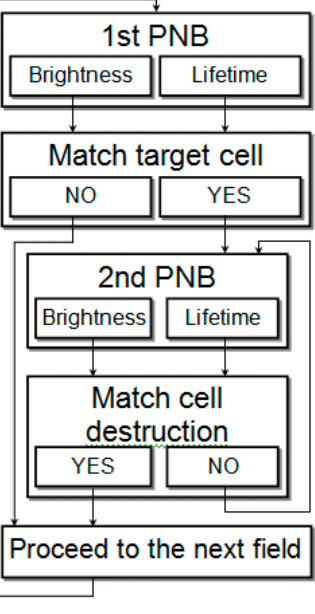
Figure 16. Algorithm of cell theranostics with two sequential PNBs of different sizes provides the three connected steps of diagnosis, cell ablation and immediate guidance of the cell ablation through PNB optical